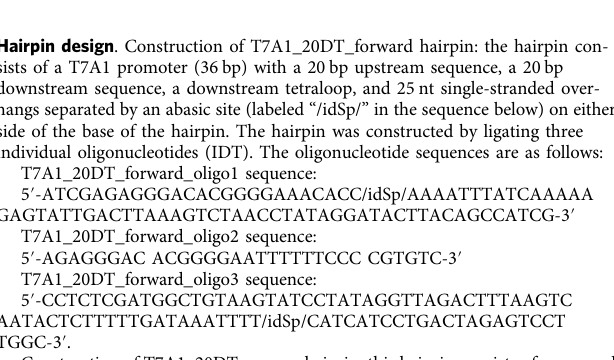
TGGC-3 ′ . Construction of T7A1_20DT_reverse hairpin: this hairpin consists of a reversed stem sequence relative to the T7A1_20DT_forward hairpin. In this